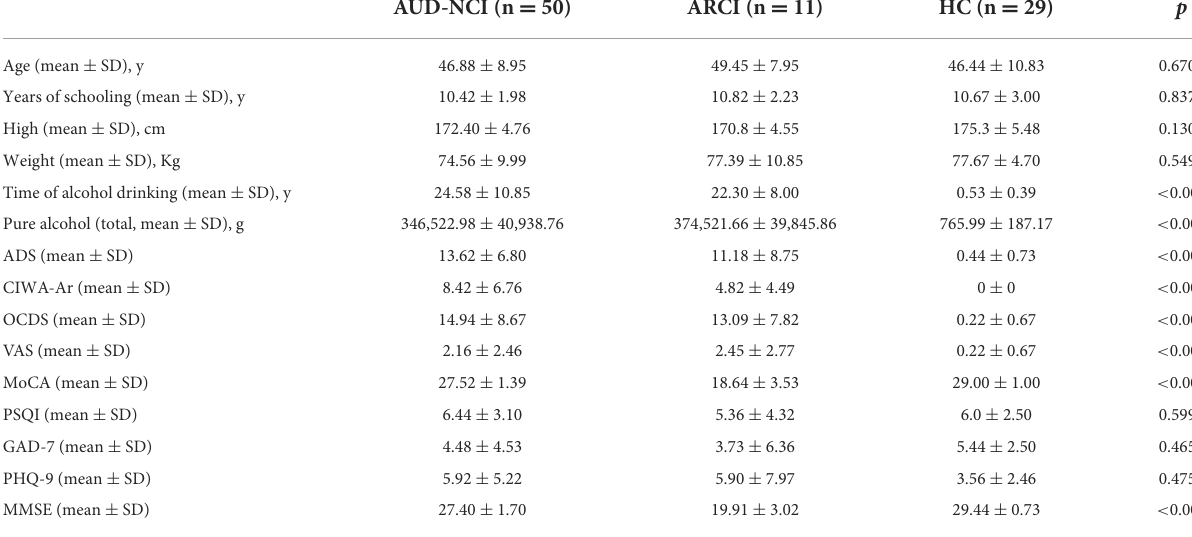
TABLE 1 Demographics of subjects (one-way